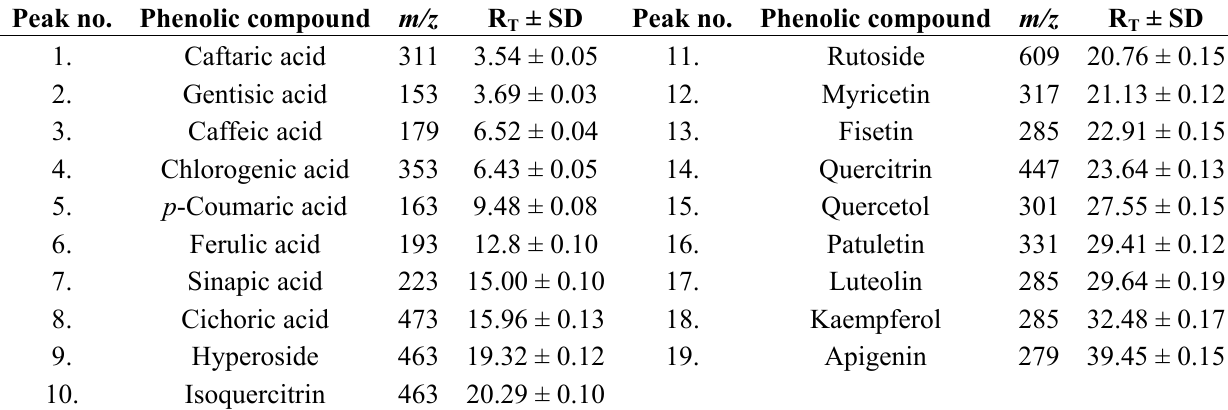
) of polyphenolic compounds T